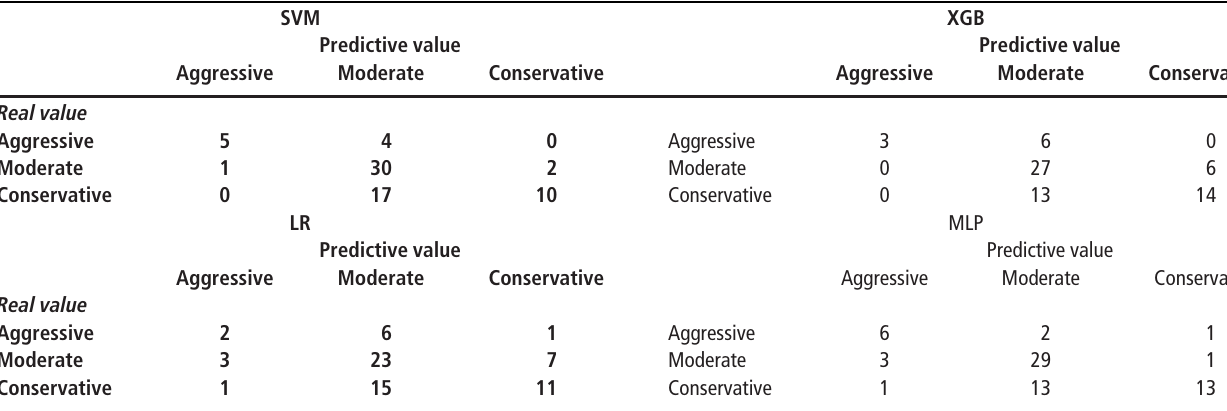
Table 8 Different machine learning model prediction results